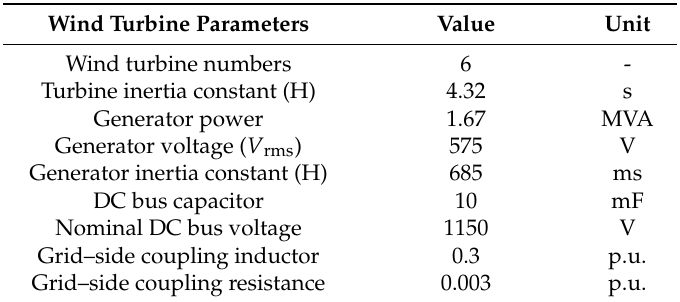
Table 4. The parameters of the wind power plant.